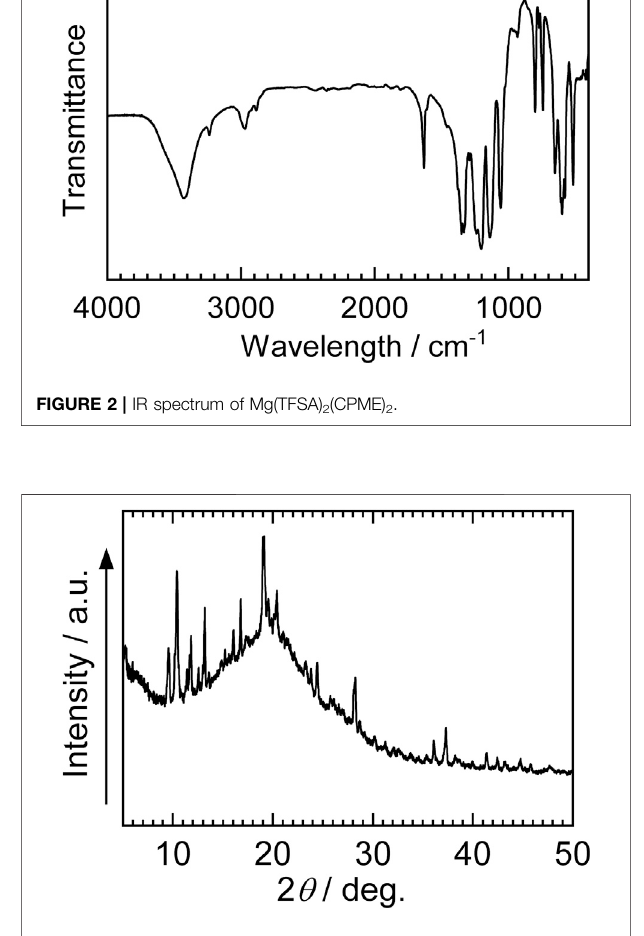
FIGURE 3 | Powder XRD pattern of Mg(TFSA) 2 (CPME) 2 . (The broad peak observed in the range of 15 ° – 25 ° is derived from the Kapton fi lm employed to prevent Mg(TFSA) 2 (CPME) 2 from absorbing moisture.).